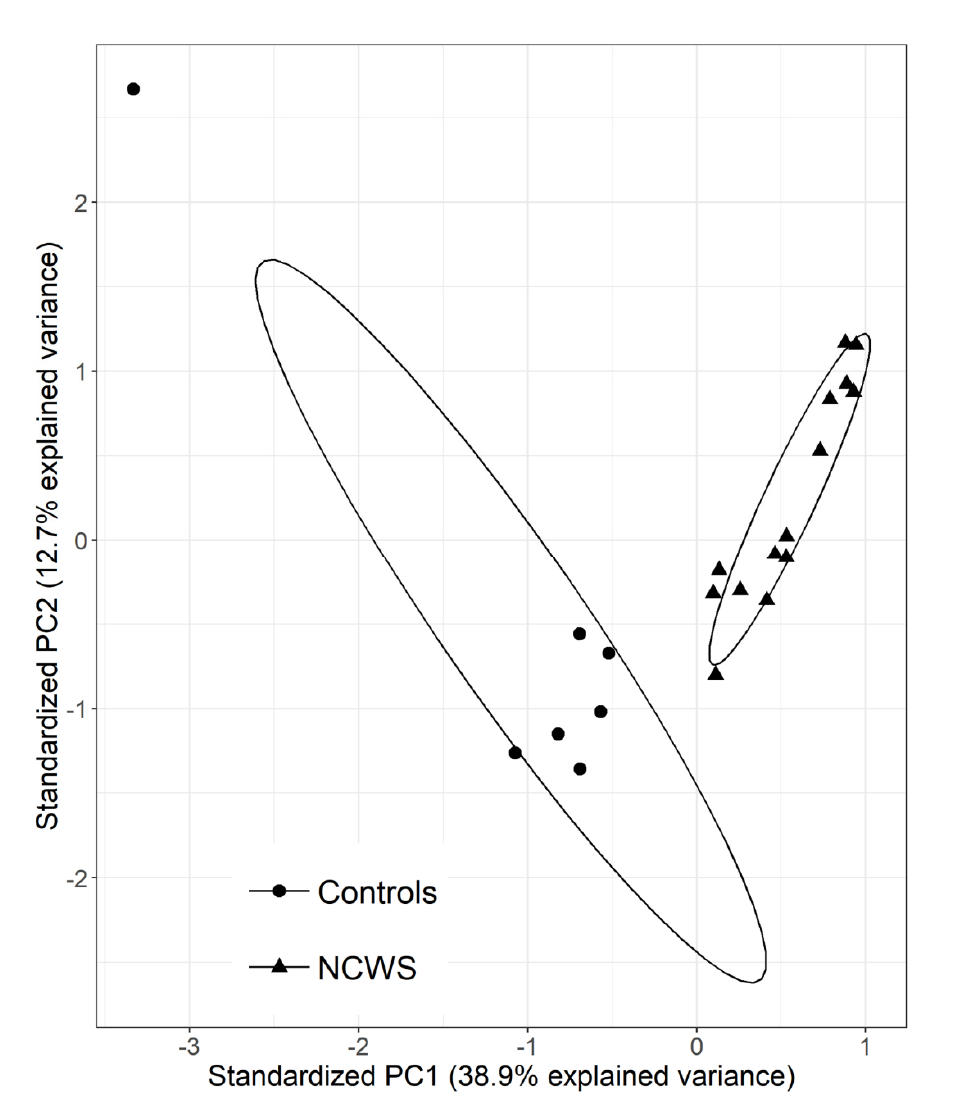
Figure 2. Principal component analysis of the DE transcripts. Scatter plot of the first two components (principal component (PC)1 and PC2) of the DE expressed transcripts between NCWS and controls with 95% confidence ellipses. ▲ : NCWS, and • : controls.